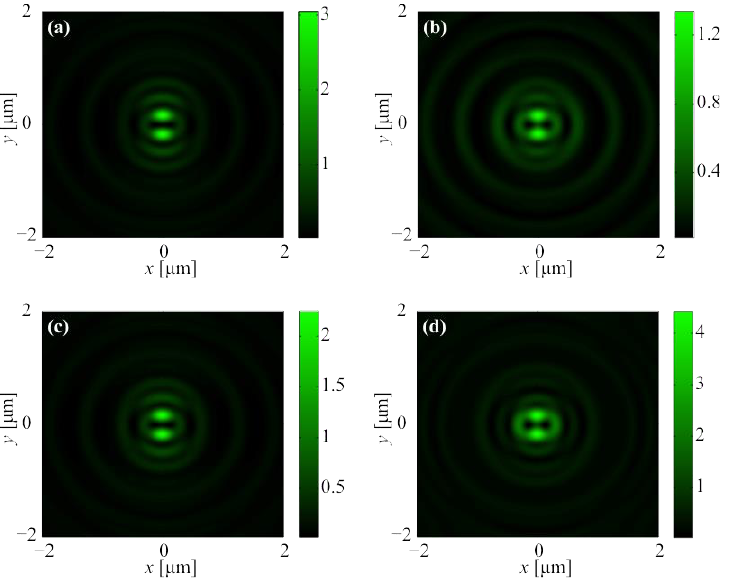
Figure 12. The averaged pattern of the intensity of the second-order CVB in the focus of the BZP with relief from: aluminum with height of 50 nm ( a ), gold with height of 140 nm ( b ), chrome with height of 70 nm ( c ), and quartz with height of 532 nm ( d ).